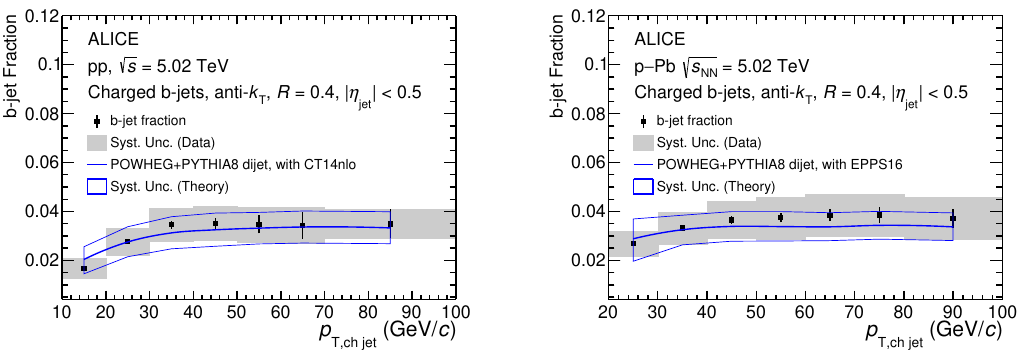
√ s = 5 . 02 TeV (left) and p-Pb collisions at